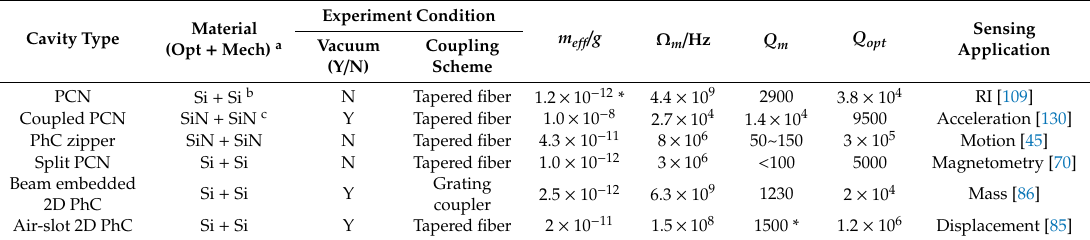
Table 5. Summary of selected experiments on radiation pressure-driven PhC